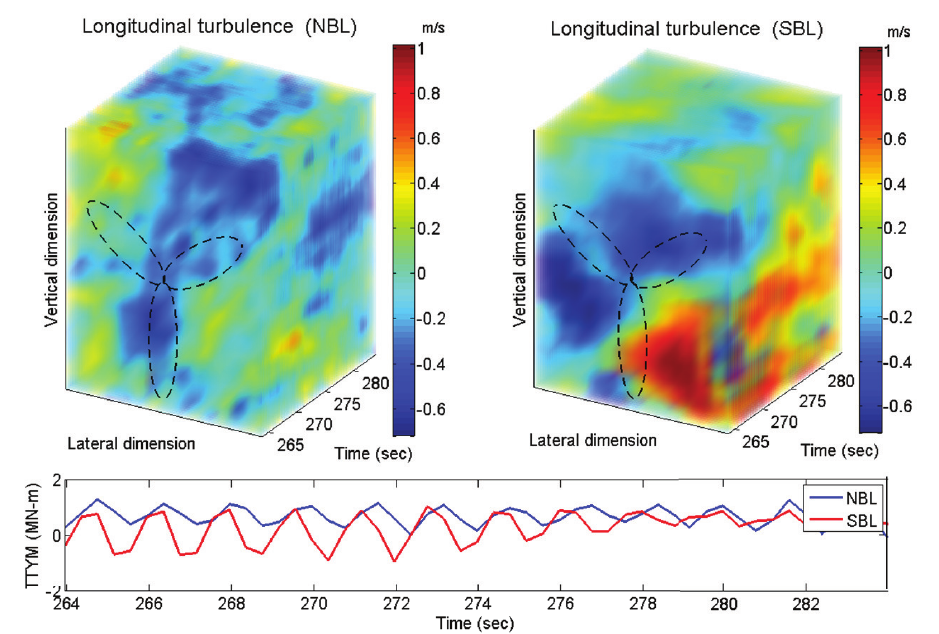
Figure 14. Effect of turbulent wind field on TTYM process for a single run